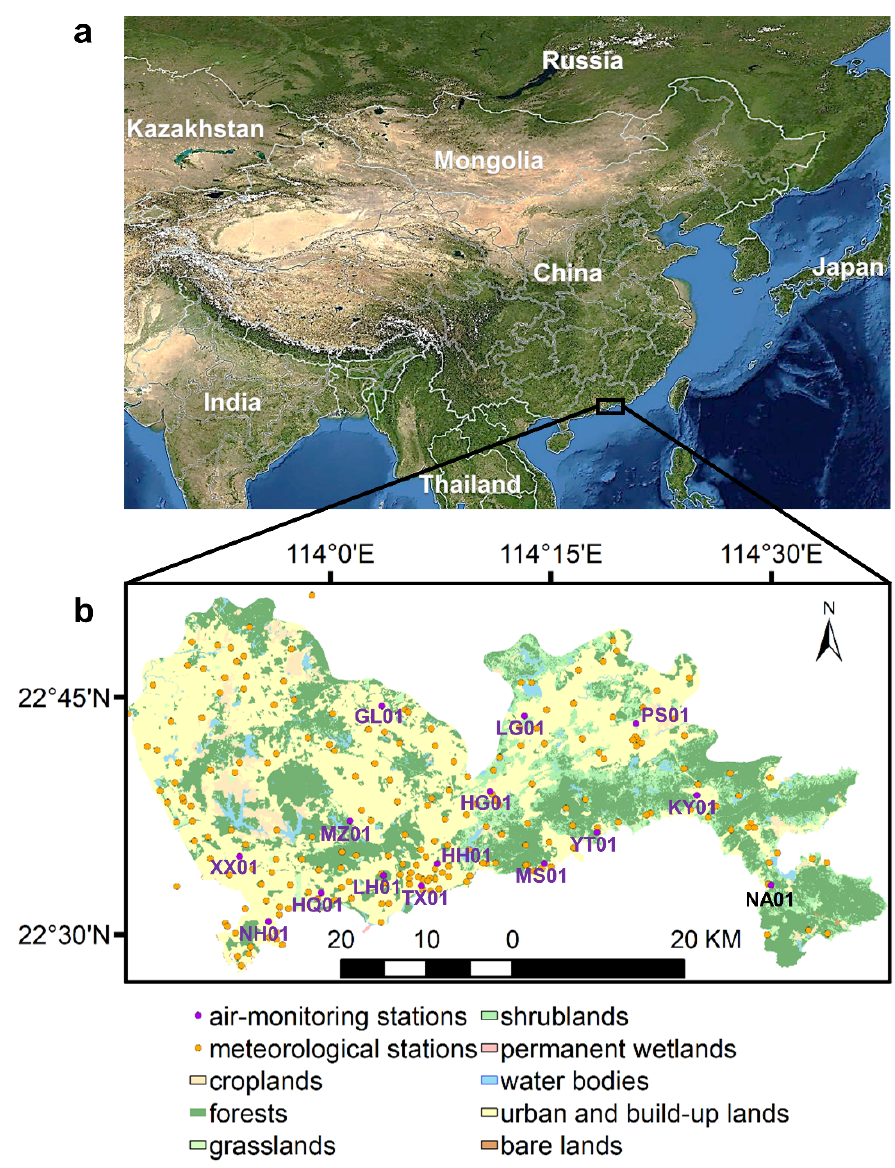
Figure 1. Geographical location of the study area. ( a ) Diagram of the geographical location of Shenzhen; ( b ) Land cover of the study region and distribution of air pollution monitoring stations (purple, n = 15) and meteorological stations (orange, n = 209). The air pollution monitoring station, Nan’ao station (NA01, black text), is unavailable and excluded.